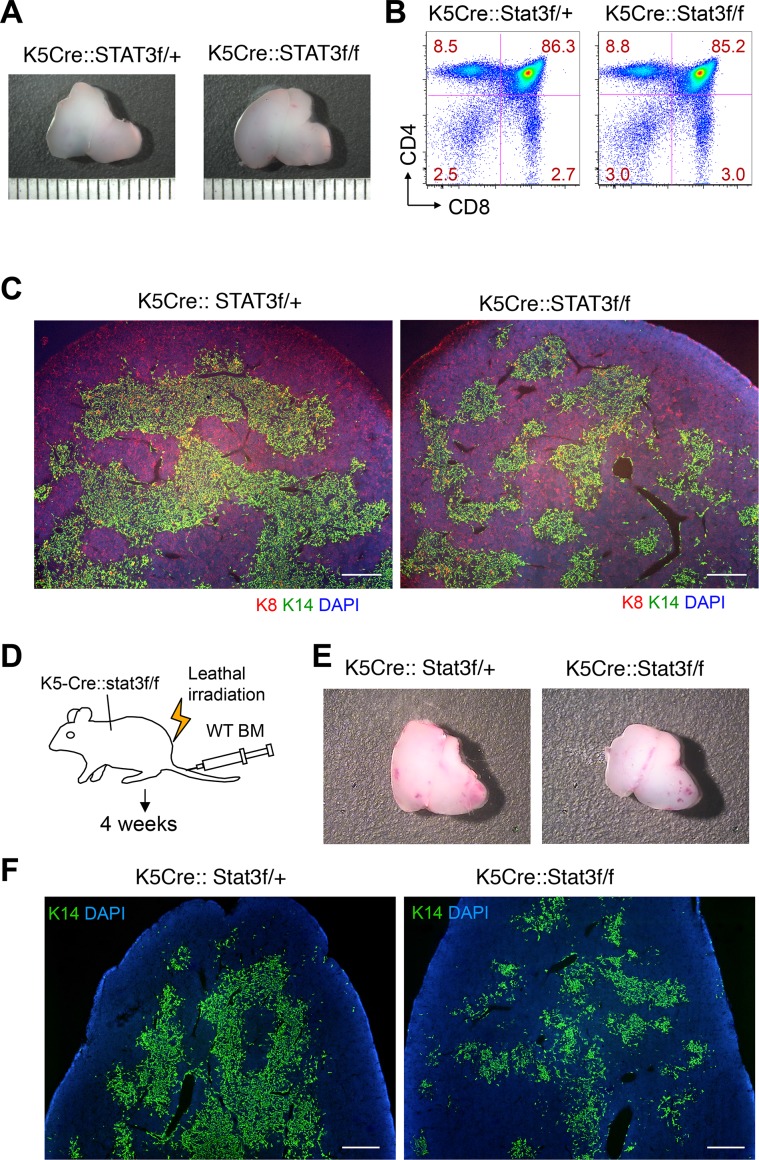
Medullary regions are severely affected while cTECs were normally regenerated in K5-Cre-Stat3-CKO mice.(A) Gross anatomical analysis of the thymus derived from 7 week old K5Cre::Stat3f/+ and K5Cre::Stat3f/f mice. Scale bars: 1 mm. (B) CD4 and CD8 cell surface expression on thymocytes derived from 7 week old Stat3f/f and K5Cre::Stat3f/f mice. (C) Cryostat sections of thymic tissues derived from either K5Cre::Stat3f/+ or K5Cre::Stat3f/f mice at 7 weeks of age. The tissues were stained with anti-K8 (red) and anti-K14 (green) antibody and counterstained with DAPI (blue). Scale bars: 400 μm. (D) Experimental design for data presented in panels (E) and (F). K5-Cre::Stat3-f/f mice were lethally irradiated and then rescued by hematopoietic stem cell transplantation (wild type C57BL/6). After 4 weeks, mice were sacrificed and the thymus was examined. (E) Gross anatomical analysis of the grafted thymus 4 weeks after hematopoietic stem cell transplantation. (F) Cryostat sections of the thymus were stained with anti-K14 antibody (green) and counterstained with DAPI (blue). Scale bars: 400 μm.